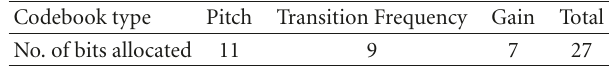
Table 3: Bits allocation for pitch, transition frequency, and gain codebooks.